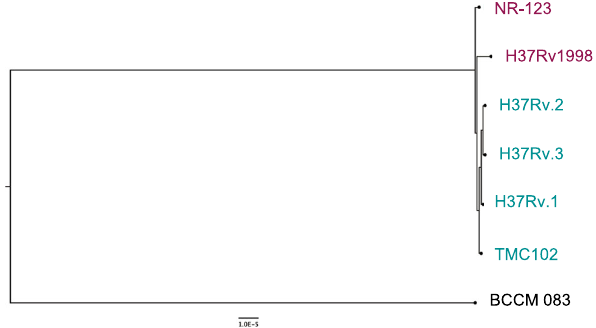
Fig. 4 | Phylogenetic analysis of H37Rv strains used in the study. H37Rv strains were assembled with Bact-Builder, sequence alignment was completed using Bowtie2 via REALPHY 68 (https://realphy.unibas.ch/fcgi/realphy), and a maximum likelihoodtreewasconstructedwithRaxML 69 .ThetreewasrootedwithBCCM083, a M. tuberculosis Lineage 1 strain 70 .